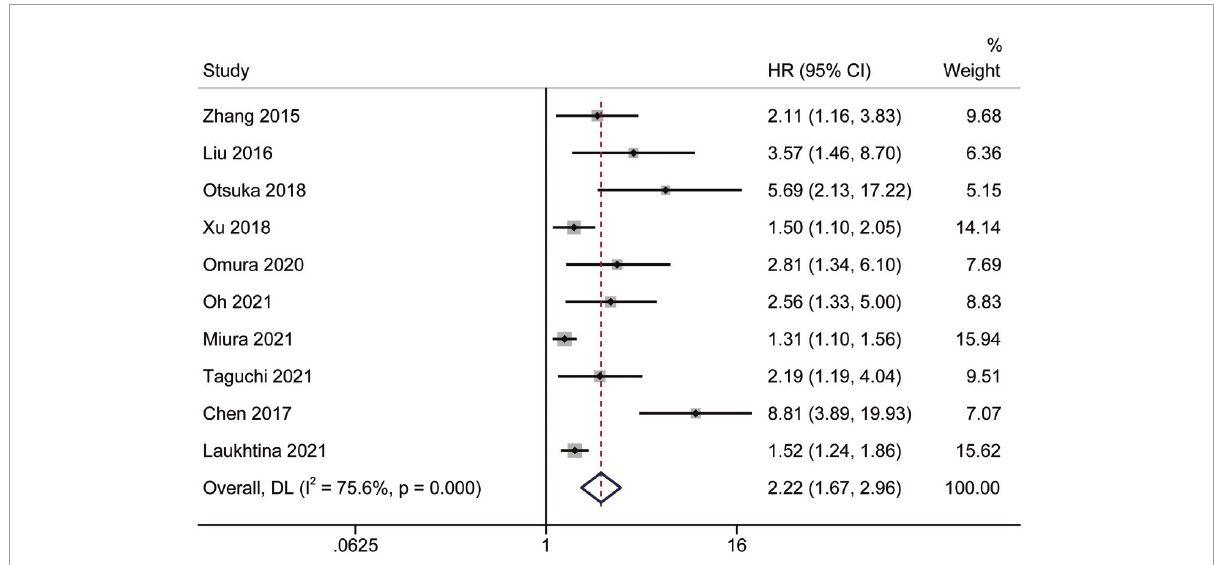
FIGURE4 Forest plot reflects the association between AGR and CSS for urological